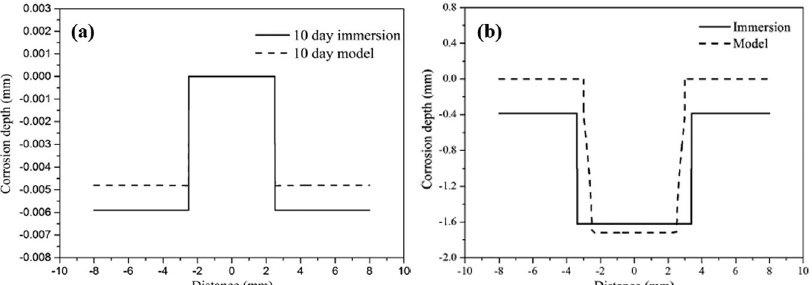
Fig. 3 Surface corrosion pro fi les predicted by simulation and experimental methods. a Results from the numerical model and immersion tests after ten days of immersion in 3.5 wt.% NaCl solution. b Results from numerical model and potential polarization tests after 6 days of immersion in the electrolyte solution 52 . Reproduced with permission from ref. 52 , copyright (Springer Nature,